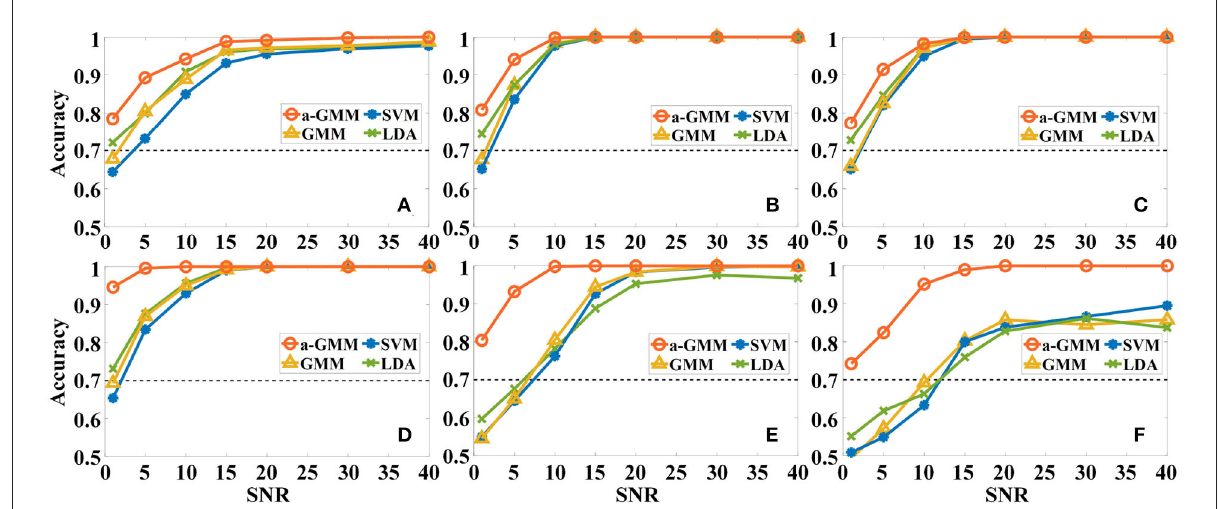
FIGURE7 The effect of different levels of Gaussian white noise on the classification accuracies of the four classifiers based on the level feature. (A–F) Correspond to the accuracy results of simulations 1–6.